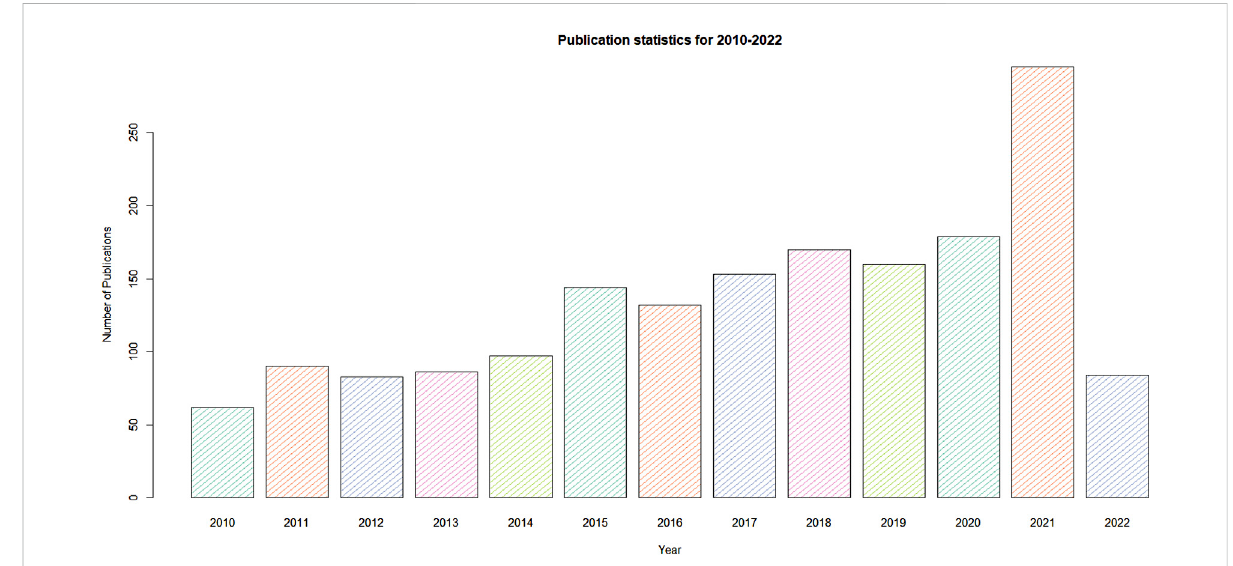
FIGURE 1 Graphical representation of manuscripts published from 2010 to 2022 on identi fi cation of medicinal plants using DNA